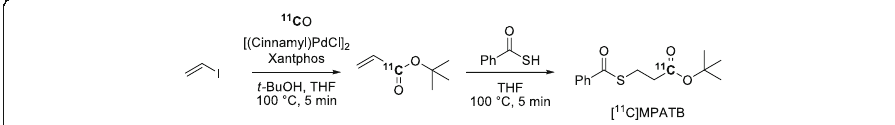
Fig. 29 Synthesis of [ 11 C]MPATB through Pd-mediated 11 C-carbonylation followed by a thiol-ene